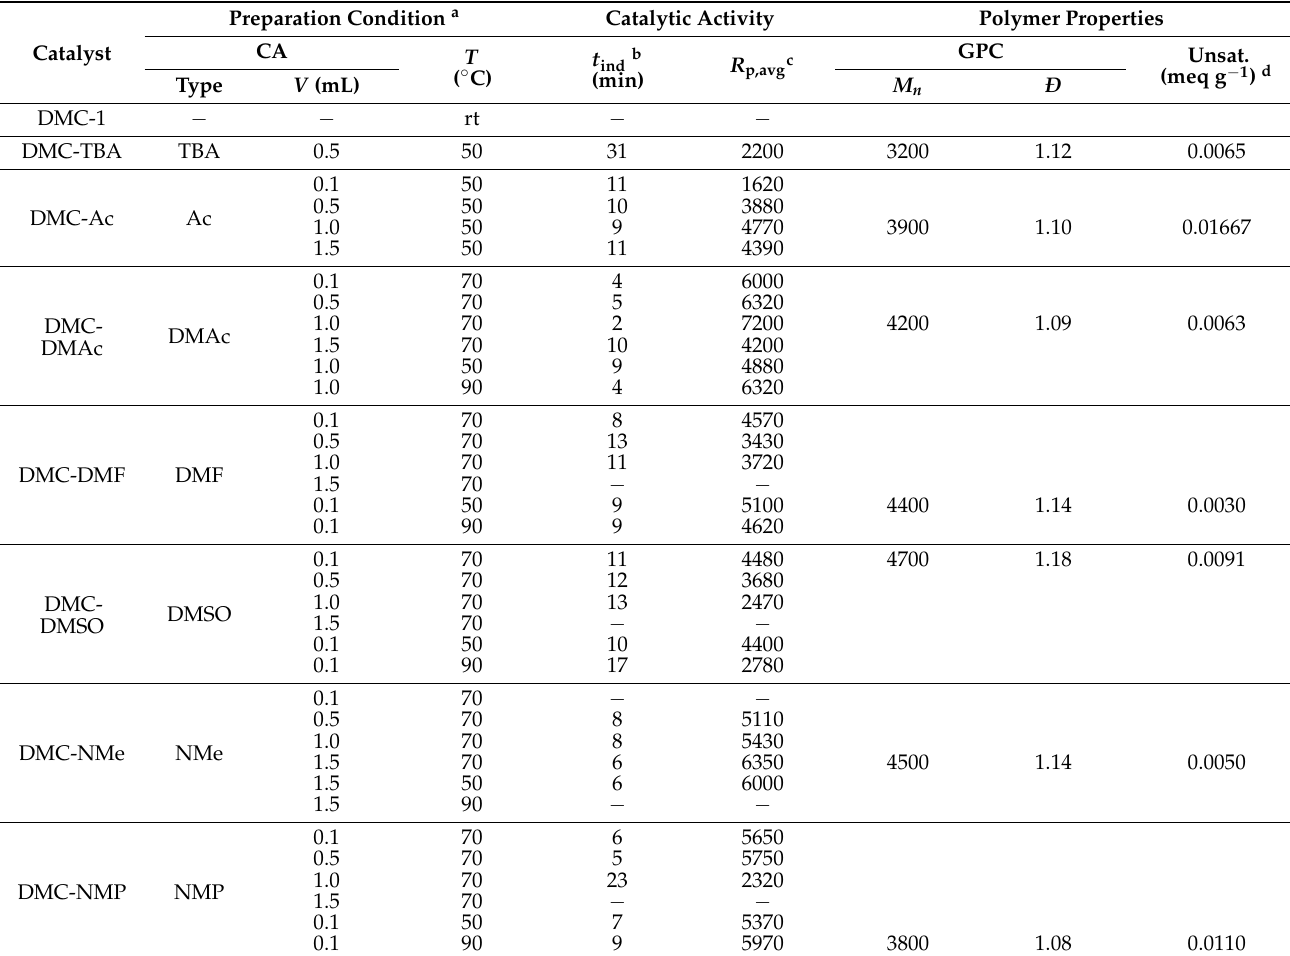
Table 3. Results of the ROP of PO using various DMC catalyst.